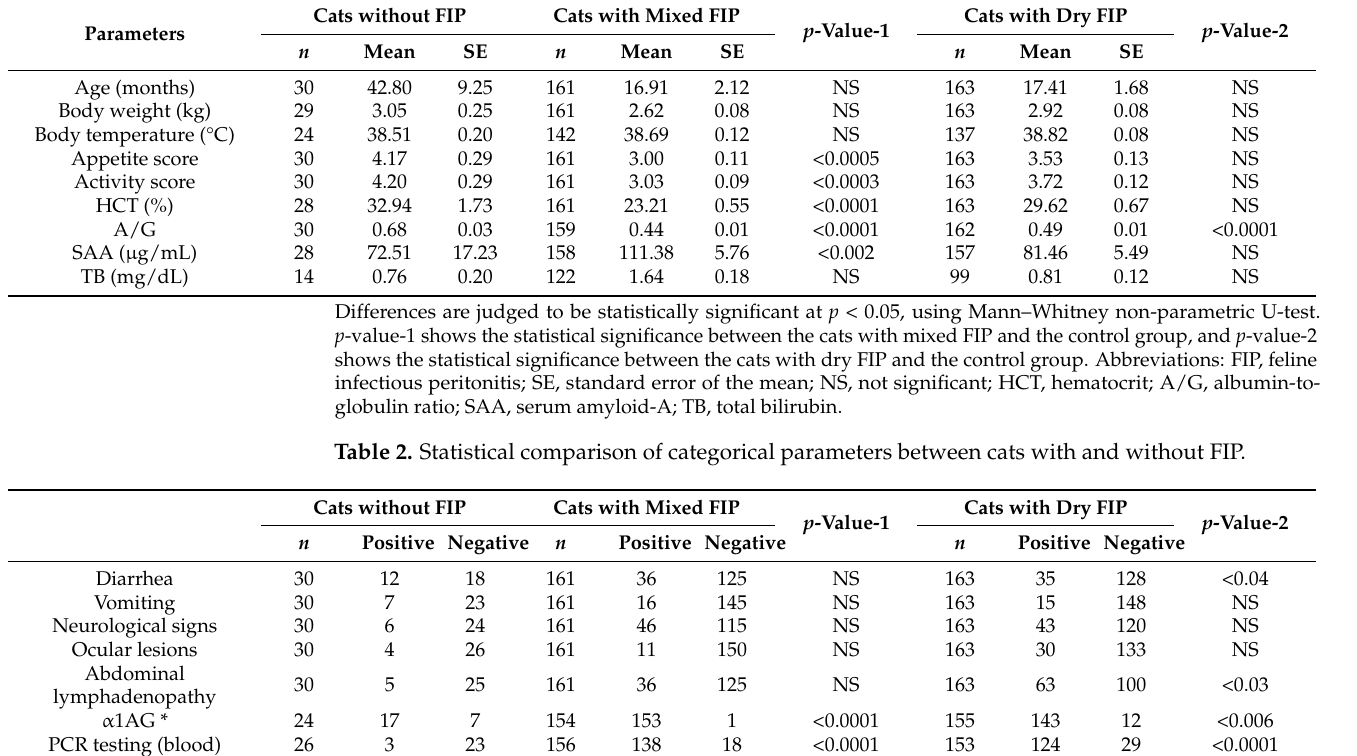
Table 1. Statistical comparison of signalment and clinical parameters between cats with and without FIP.